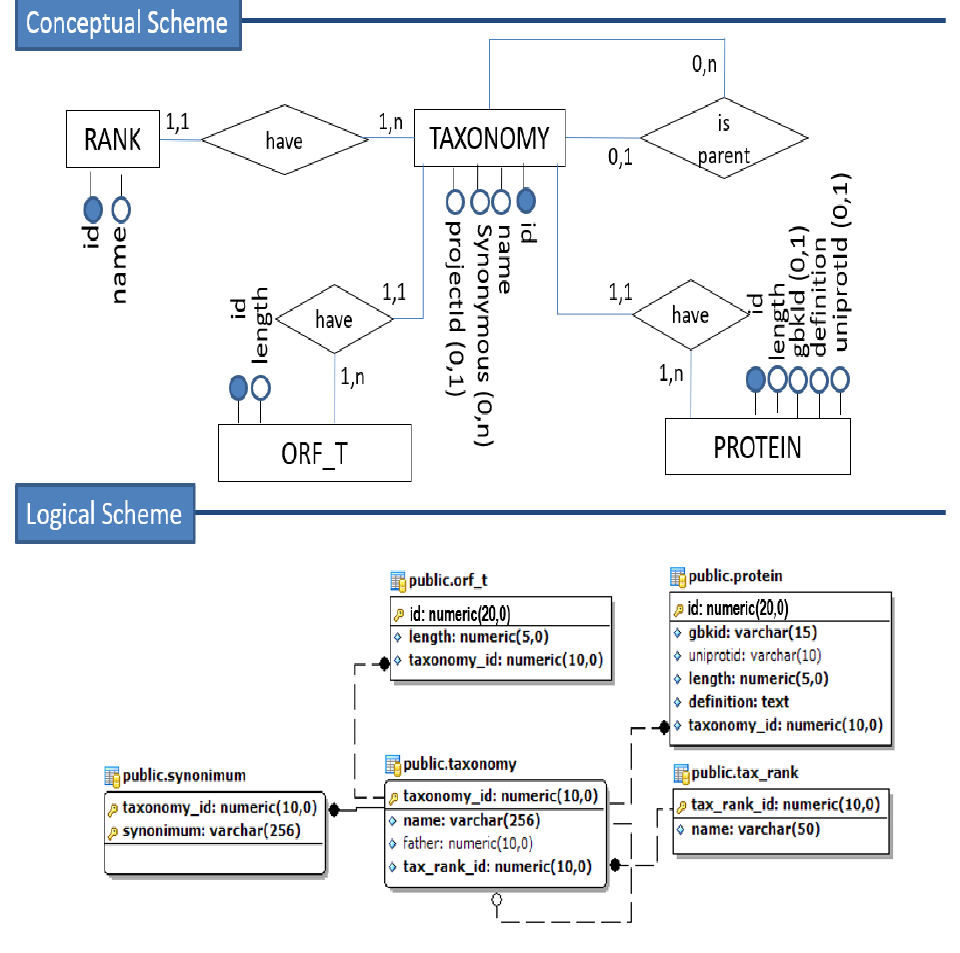
Figure 2. Conceptual to Logical Mapping—part